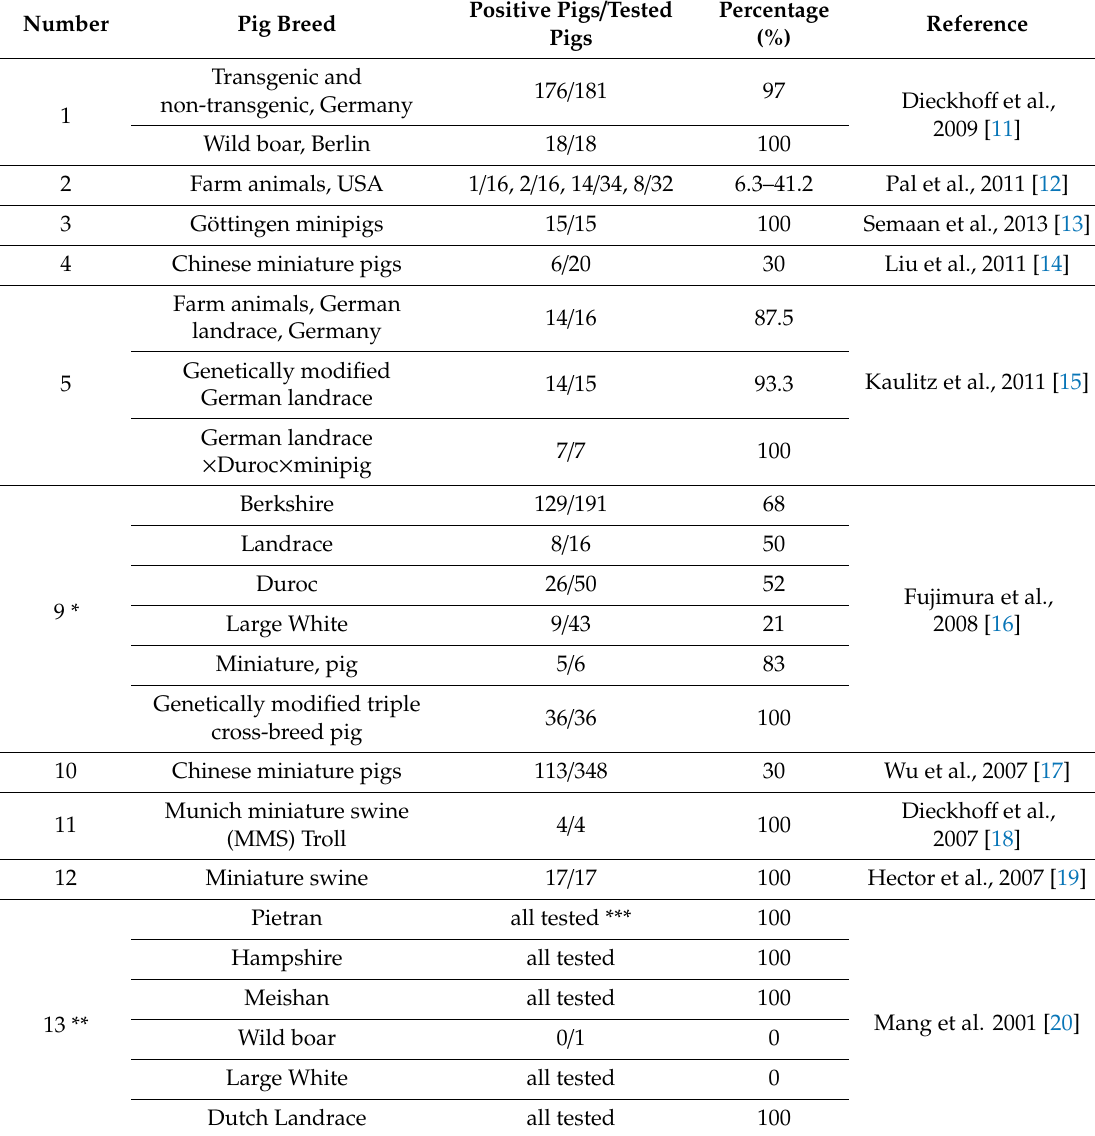
Table 1. Prevalence of Porcine endogenous retroviruse (PERV)-C in di ff erent pig breeds. Wild boars are shown in position 1 and